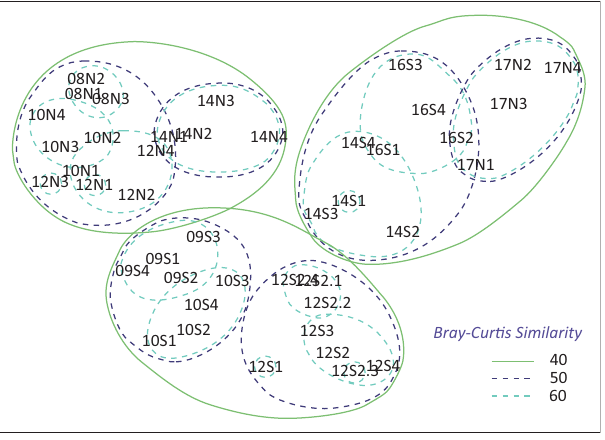
Stress = 0.12. FIGURE 6: Non-metric multidimensional scaling of ant assemblages for samples pooled within each of the 44 replicates across 11 sampling sites in the Soutpansberg Mountain